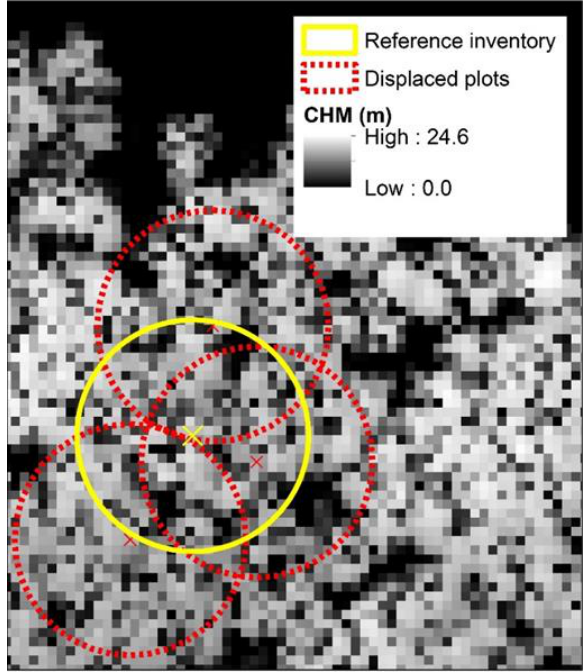
Figure 2. Example of a sample plot in the Reference inventory and three replications with the same displacement. The canopy height model (CHM) is displayed in the background showing its variation inside sample plots when altering the center coordinates.